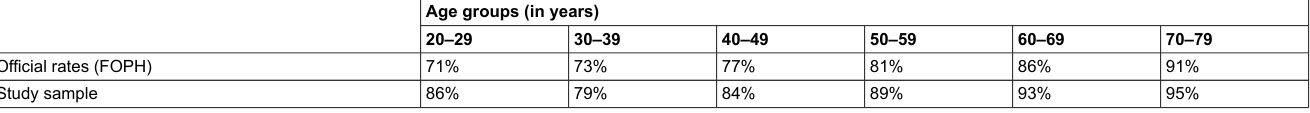
Table 3: COVID-19 vaccine uptake of the study population and of the general population according to official vaccination rates provided by the Federal Office of Public Health (FOPH) by age group as of 16 December